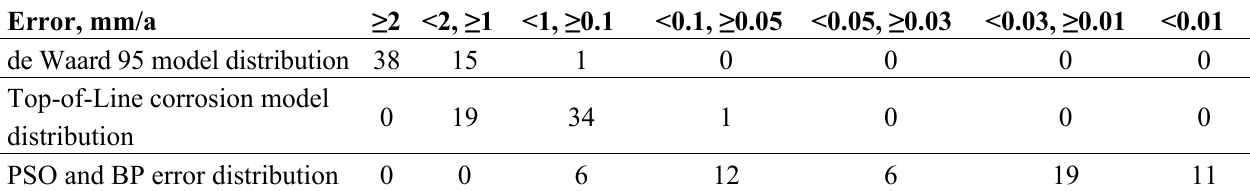
Table 14. The distribution of the prediction errors of the GA and BP for the validation